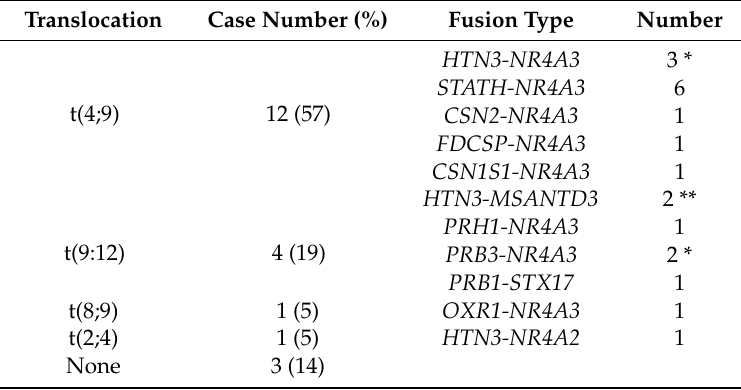
Table 2. New translocations and gene fusions of acinic cell carcinomas. Translocation Case Number (%) Fusion